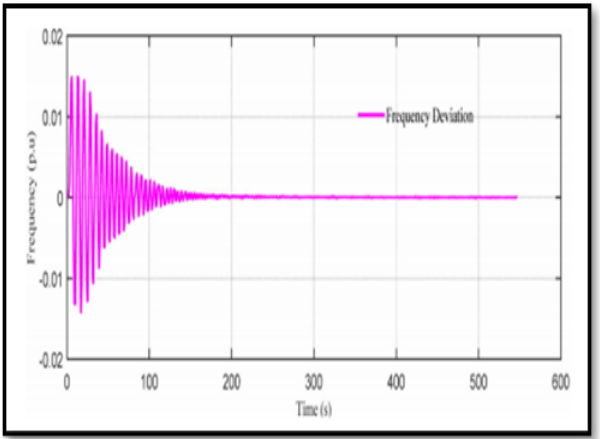
Figure 4. Responses of the frequency deviation without BES in area 1